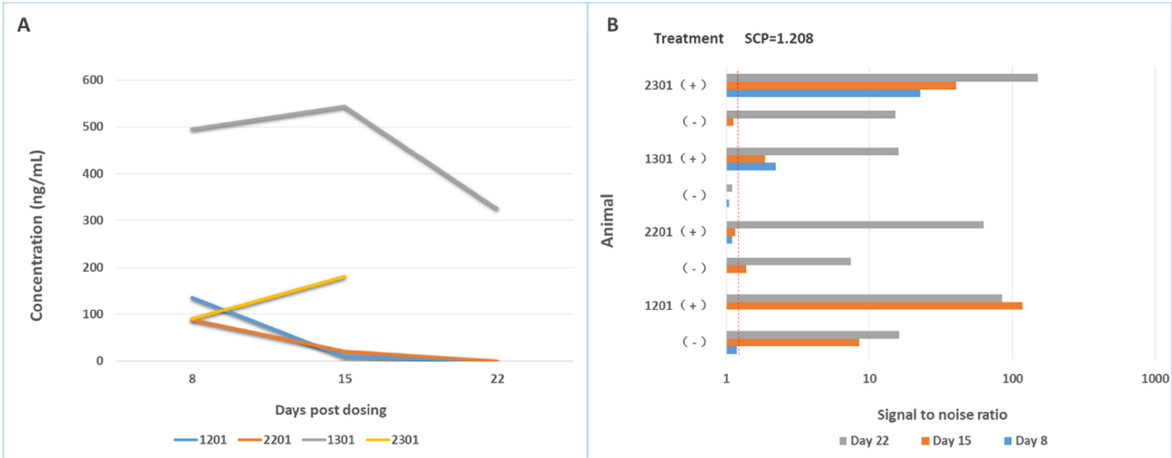
Figure 6. Drug interference on the bridging assay is mitigated by removal of free drug in the sample. ( A ) shows the concentrations of drugs in animal (cynomolgous monkey) samples collected at different times; ( B ) shows the signal-to-noise ratios of each sample determined with a screening assay for ADA either in the presence of a sample pre-treatment step or in the absence of a sample pre-treatment step. After removal of free drug from the samples, ADA positive animals are detected earlier and with higher ADA titers.